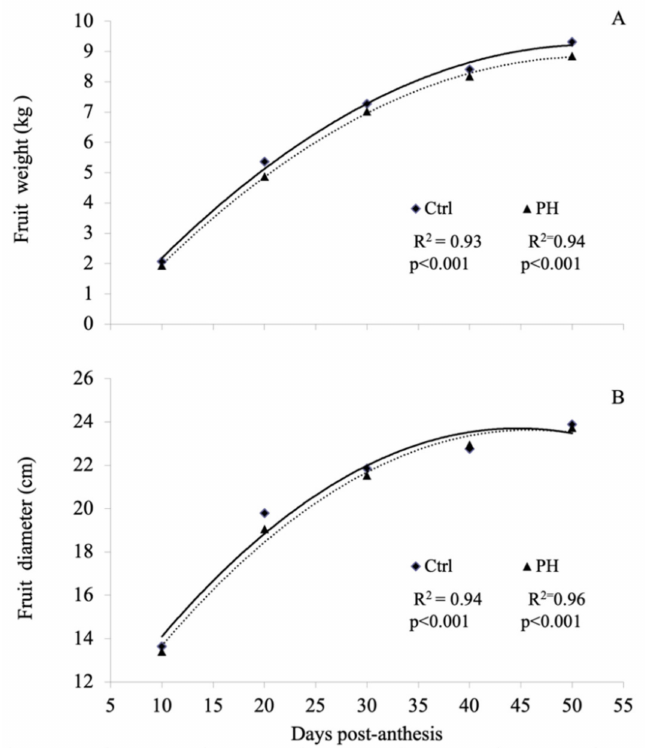
Figure 1. Regression of fruit weight ( A ) and diameter ( B ), with maturity for watermelon fruit harvested at 10, 20, 30, 40, and 50 days post-anthesis from plants with (PH) or without (Control) protein hydrolysate biostimulant application. Data points represent the means of four replicates consisting of six sample fruits